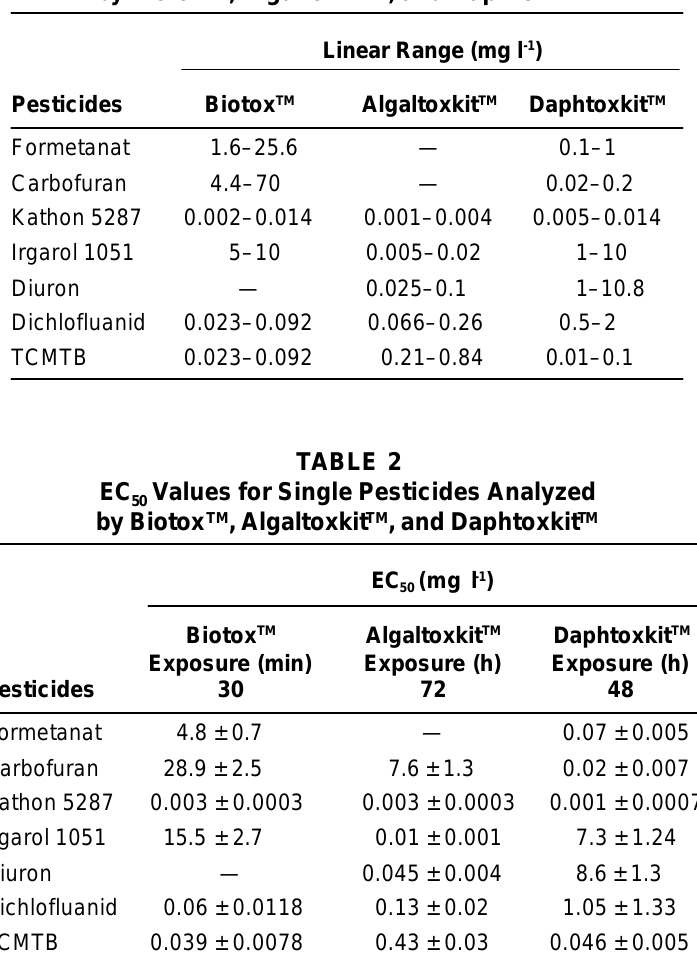
Linear Range for Single Pesticides Analyzed